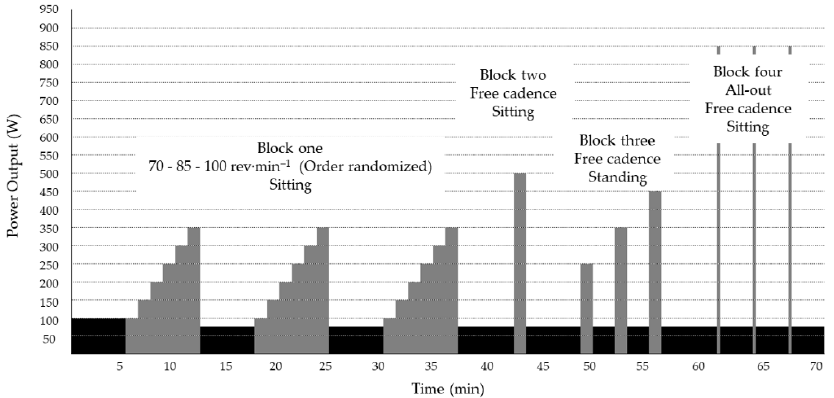
Figure 2. Graphical summary of the protocol.